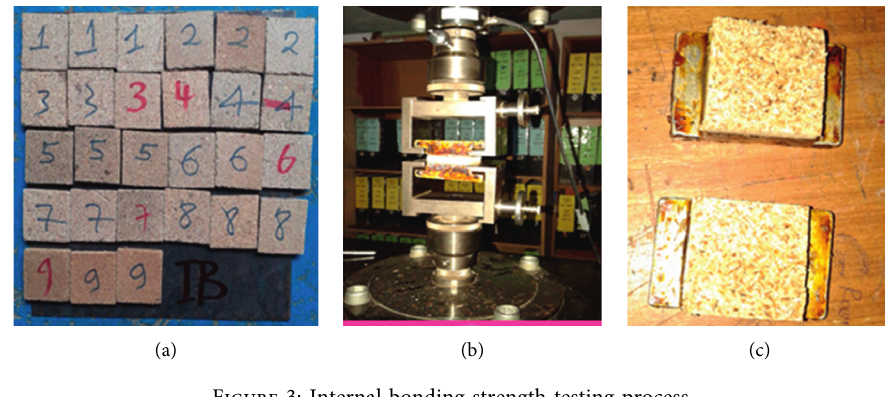
Figure 3: Internal bonding strength testing